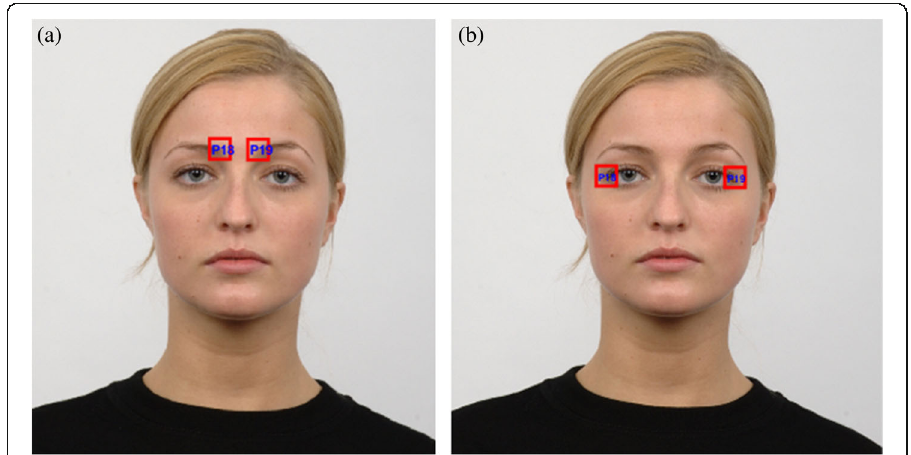
Fig. 2 Positions of facial patches P 18 and P 19 as selected by ( a ) the method of Happy et al. and ( b ) the proposed method